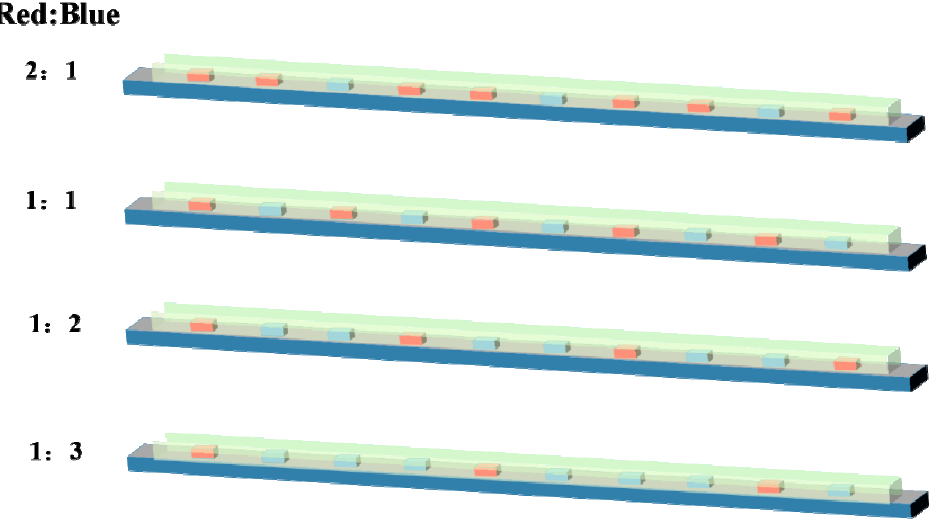
Figure 3. Samples with different chip proportions.